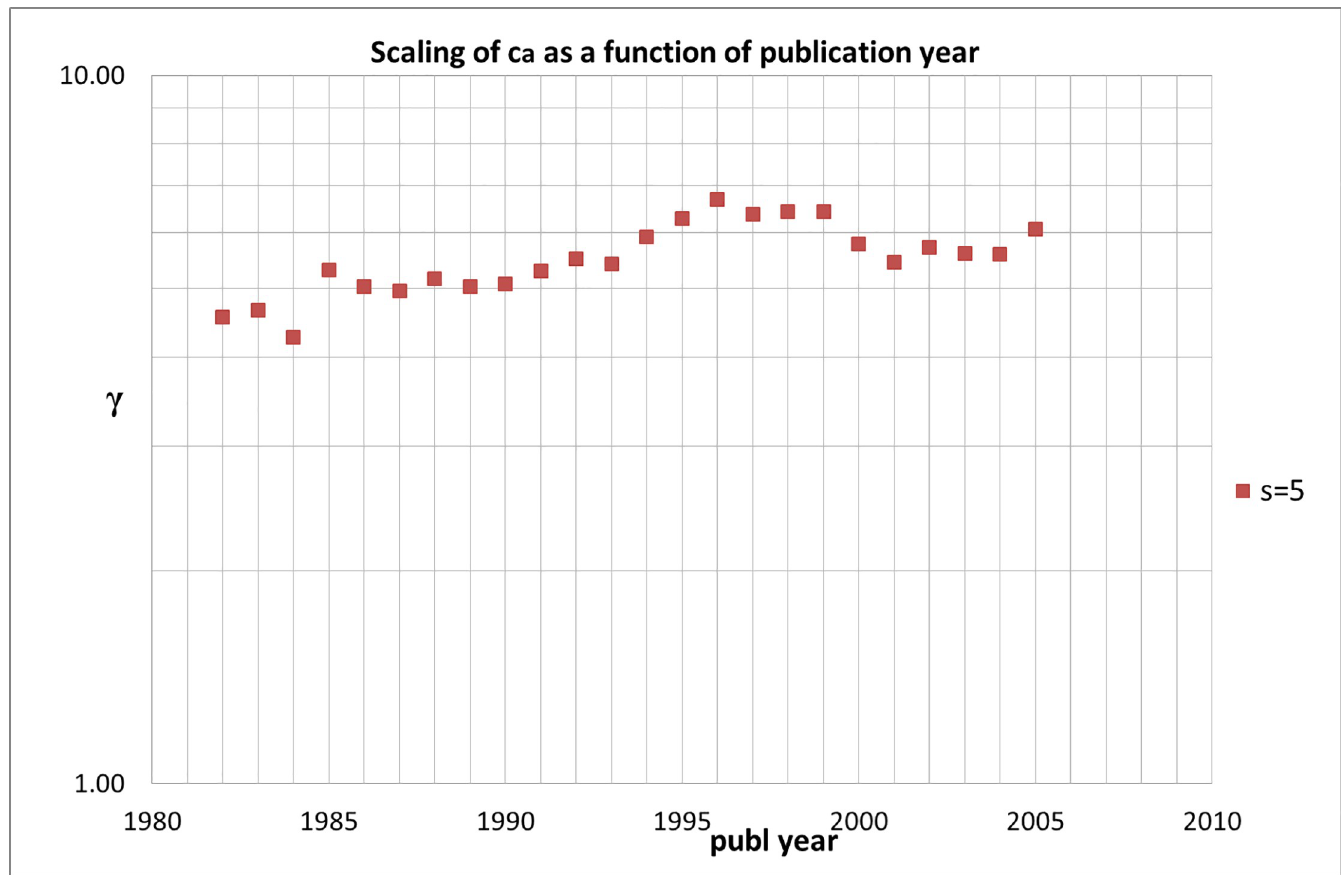
Fig 11. Scaling exponent γ for the whole measuring period 1980–2007 (because of the logarithmic scale we take the absolute values of γ